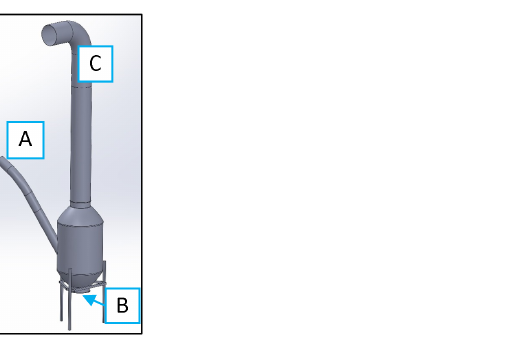
Figure 4. Diagram of an ember generator used in wildfire experiments, showing the pneumatic feed line ( A ) for feeding fuel to the generator; vertically oriented fan ( B ); and exhaust duct ( C ).